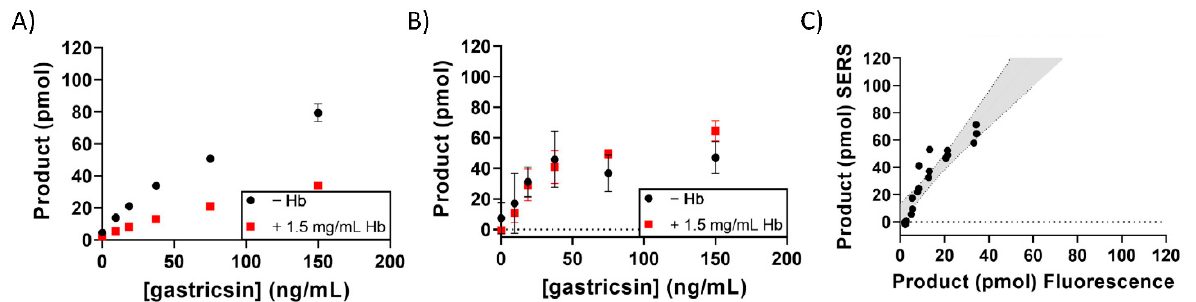
Figure 5. Gastricsin activity assay in samples comprised of a mock mucus matrix containing pancre- atic enzymes with a viscosity of 1.5 cP, while the assay buffer contained the indicated concentration of Hb to simulate a bloody pancreatic cyst fluid sample. ( A ) Measured product formation calculated from fluorescence measurement at each concentration of gastricsin as indicated on the x-axis. ( B ) Mea- sured product formation calculated from SERS measurement at each concentration of gastricsin as indicated on the x-axis. The samples are the exact same from panel ( A ). Error bars represent the standard deviation of triplicate measurements. ( C ) Correlation of product formation between SERS and fluorescence measurements from paired reaction samples. The grey area is the 95% confidence interval from a linear regression analysis with slope = 1.940 and R 2 =